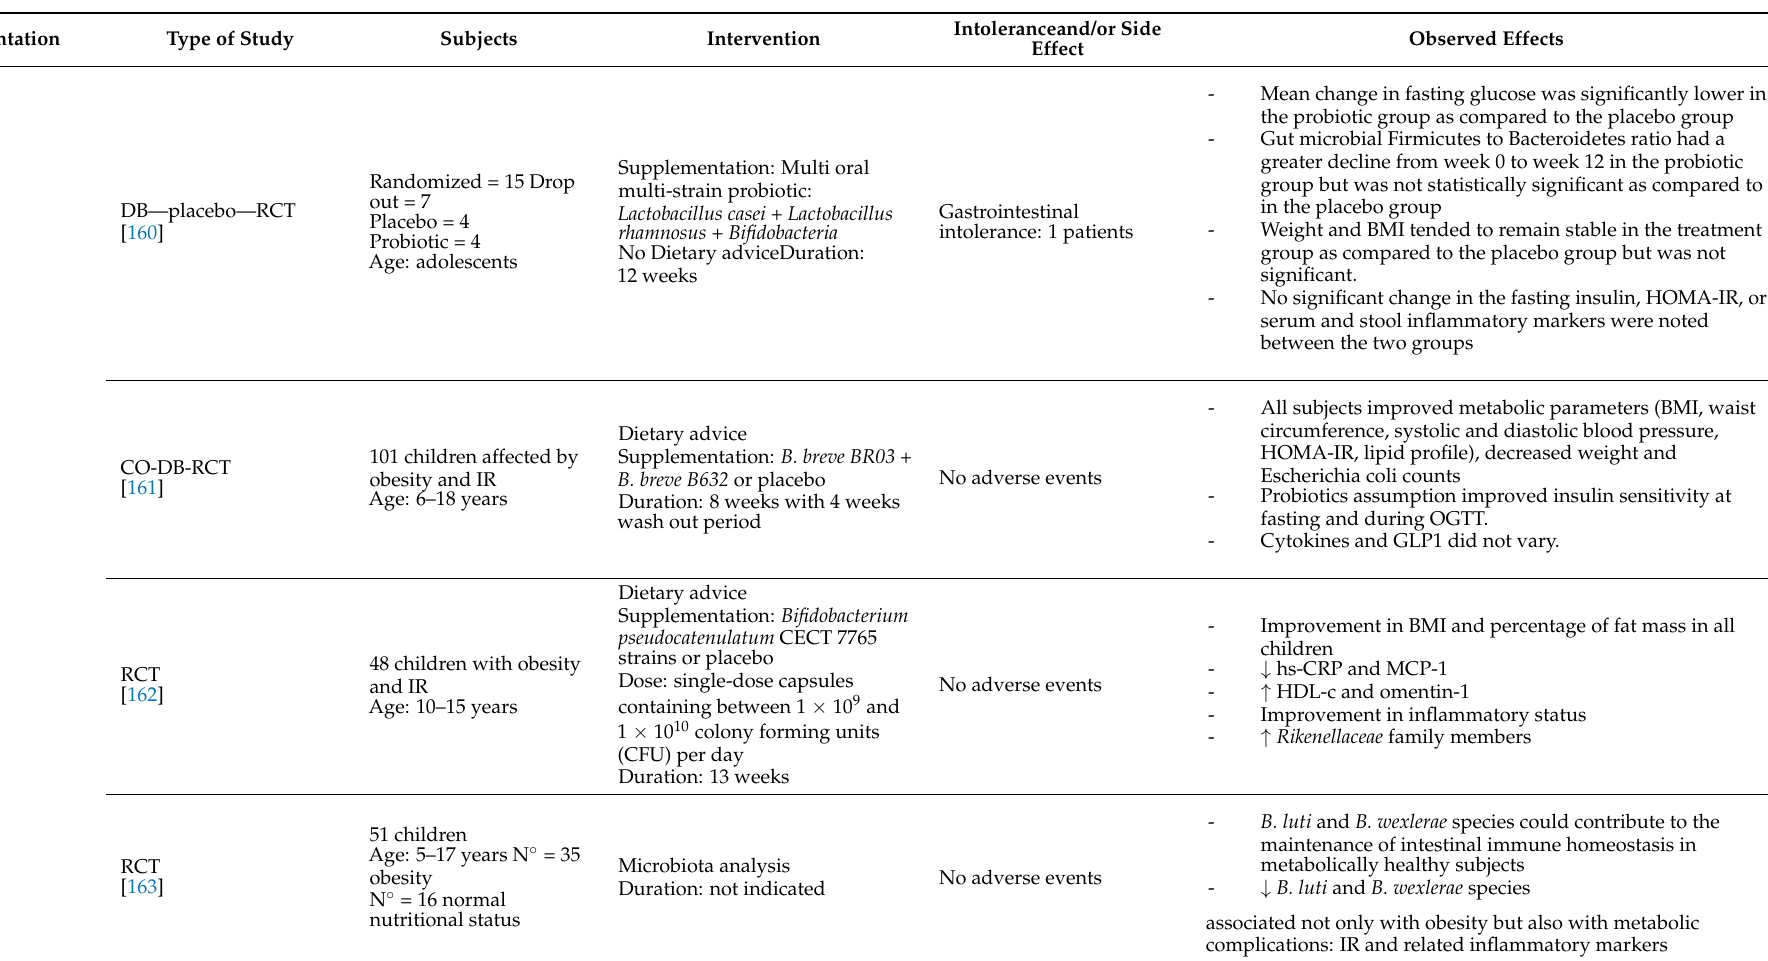
Table 1. Most relevant literature on the effects of nutritional supplementation on insulin